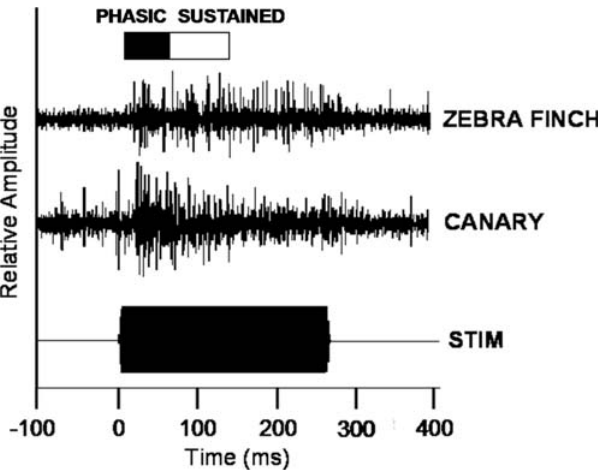
Figure 1. Representative multi-unit response traces from NCM in a zebra finch male (top) and a canary male (middle) in response to a tone stimulus. The stimulus is shown as an amplitude envelope trace (bottom). The phasic (black) and sustained (white) recording windows are shown at the top. Sites respond 10–20 ms after stimulus onset, and responding persists into the sustained period (60–130 ms). Zebra finch responses are usually greater in the sustained period than those of canaries (adapted from Terleph, Mello, and Vicario